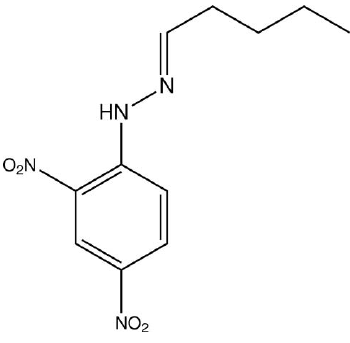
-Nonius KappaCCD area-detector diffractometer Absorption correction: multi-scan ( SADABS ; Sheldrick, 2007) T min = 0.628, T max = 1.000